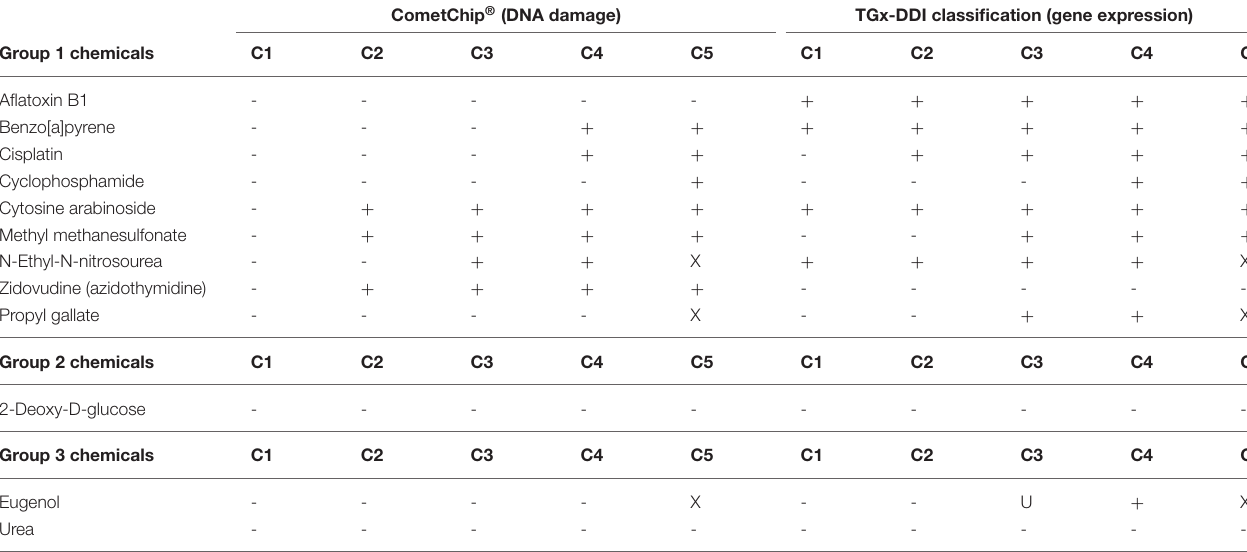
TABLE 3 | Summary of CometChip ® analysis and TempO-Seq ® TGx-DDI classification results for 12 test chemicals.